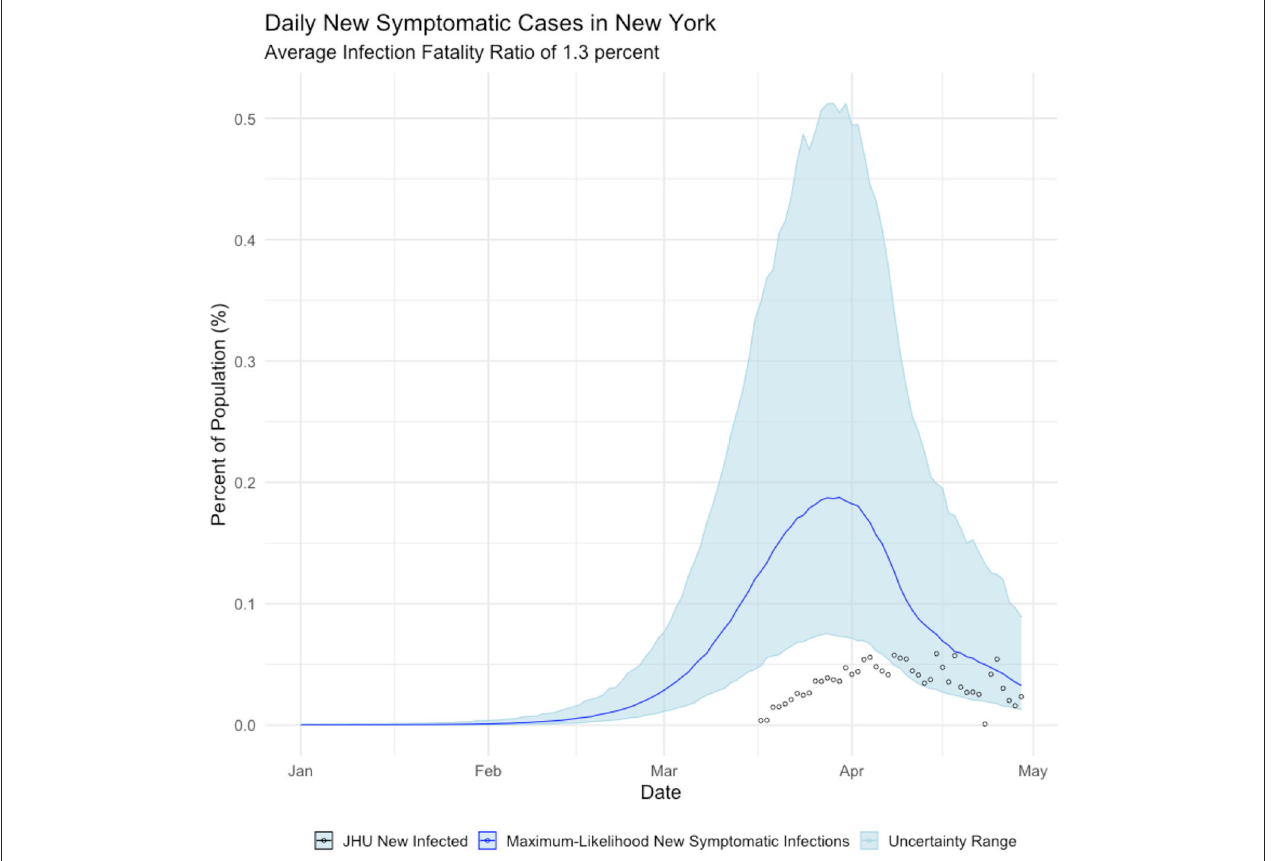
FIGURE 2 | Daily Count of New Infections, New York state. Blue line is the maximum-likelihood estimate of new symptomatic infections. Black circles are observed cases counts.